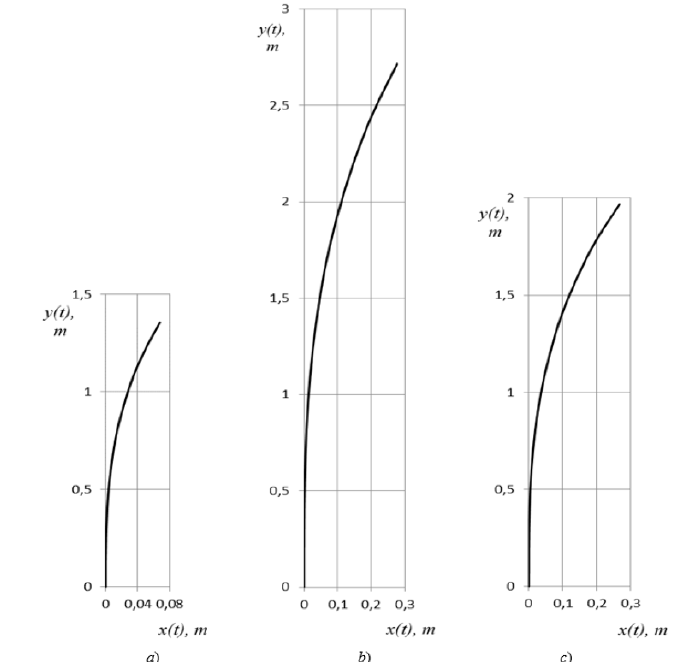
Fig. 2. Path of kinematic center of wheeled vehicle upon entering turn: (a) method I at v = 0.68 m / s : L = 2.6 m , B = 1.8 m , ω 1 = 0.28 1/ s , ω 2 = 0 1/ s , α ′′